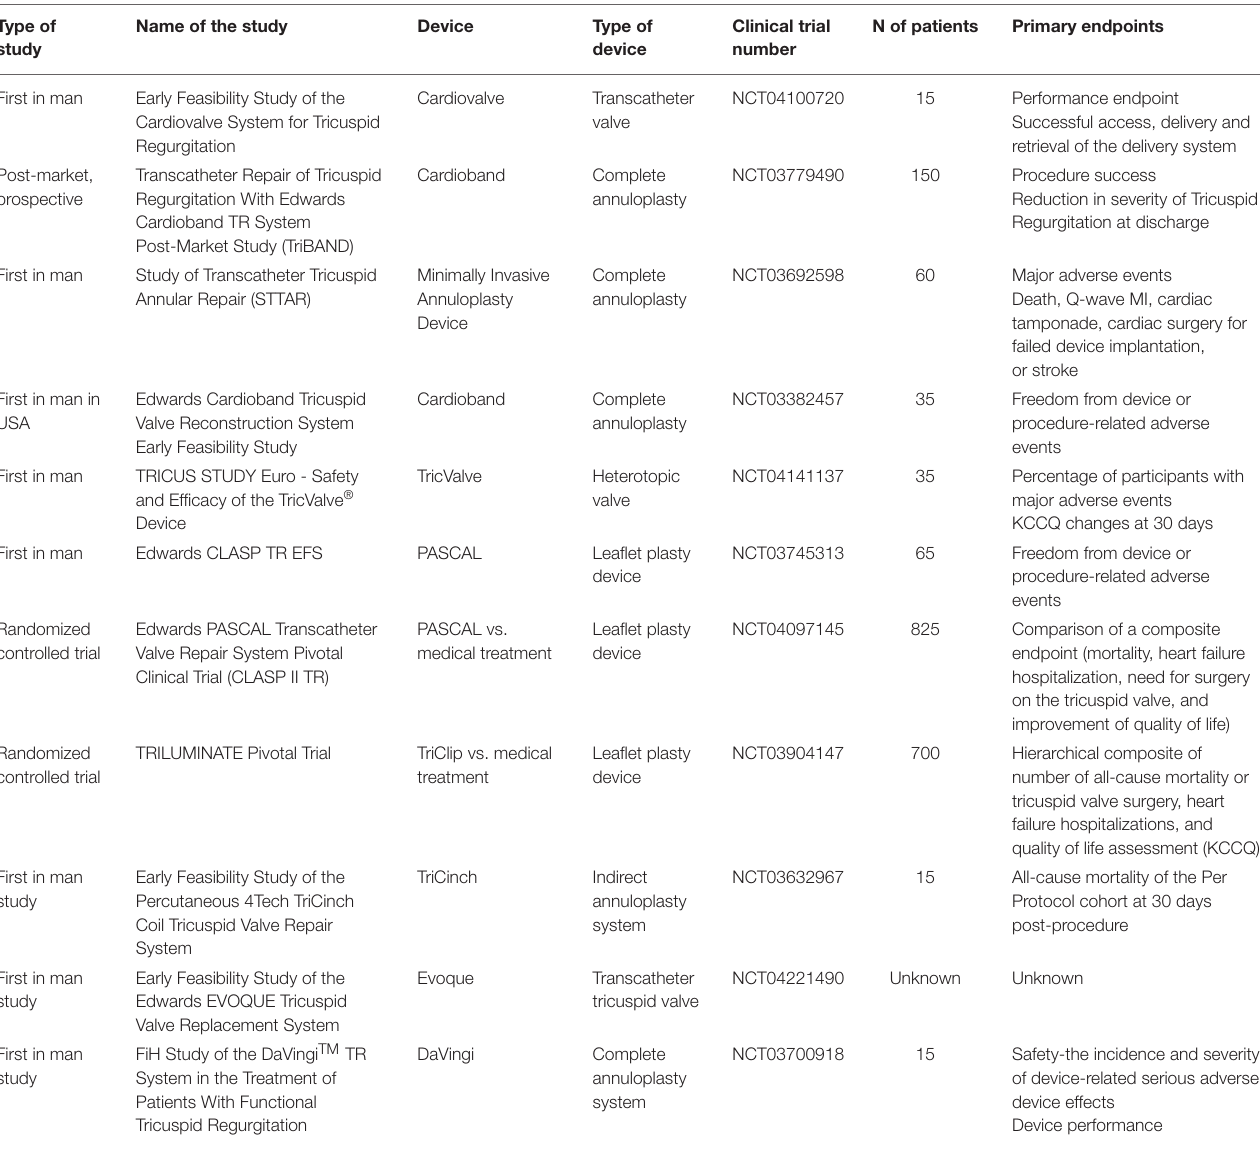
TABLE 1 | Current and future studies on percutaneous tricuspid valve